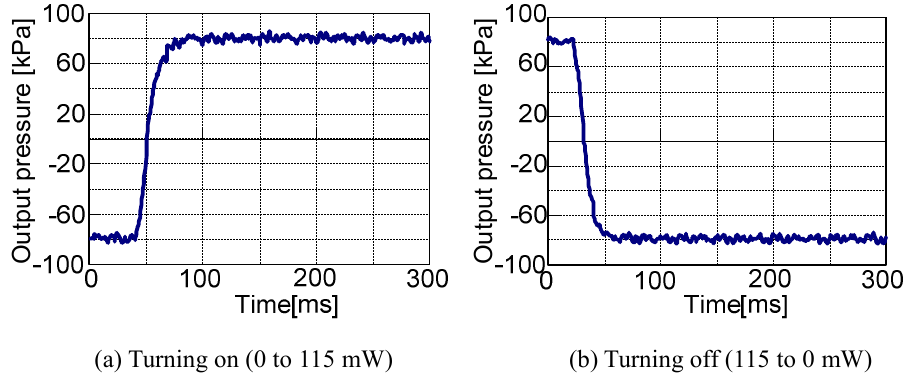
Fig. 7 Transient response of output pressure of the valve for stepwise optical input Figure 7 (a) and (b) show the transient responses of output pressure of the photo-fluidic control valve when stepwise optical power change of 115 mW was applied. In